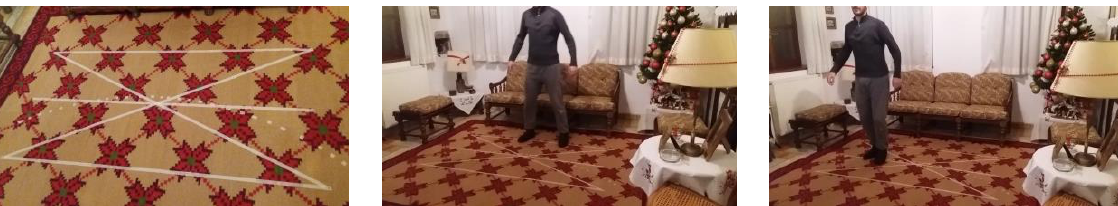
Figure 5. One of the main advantages of the system is the applicability at home, requiring minimal effort. The trajectories are marked using tape (image left). The persons’ movement is recorded and projected to the ground, in order to perform the trajectory assessment and comparison process.